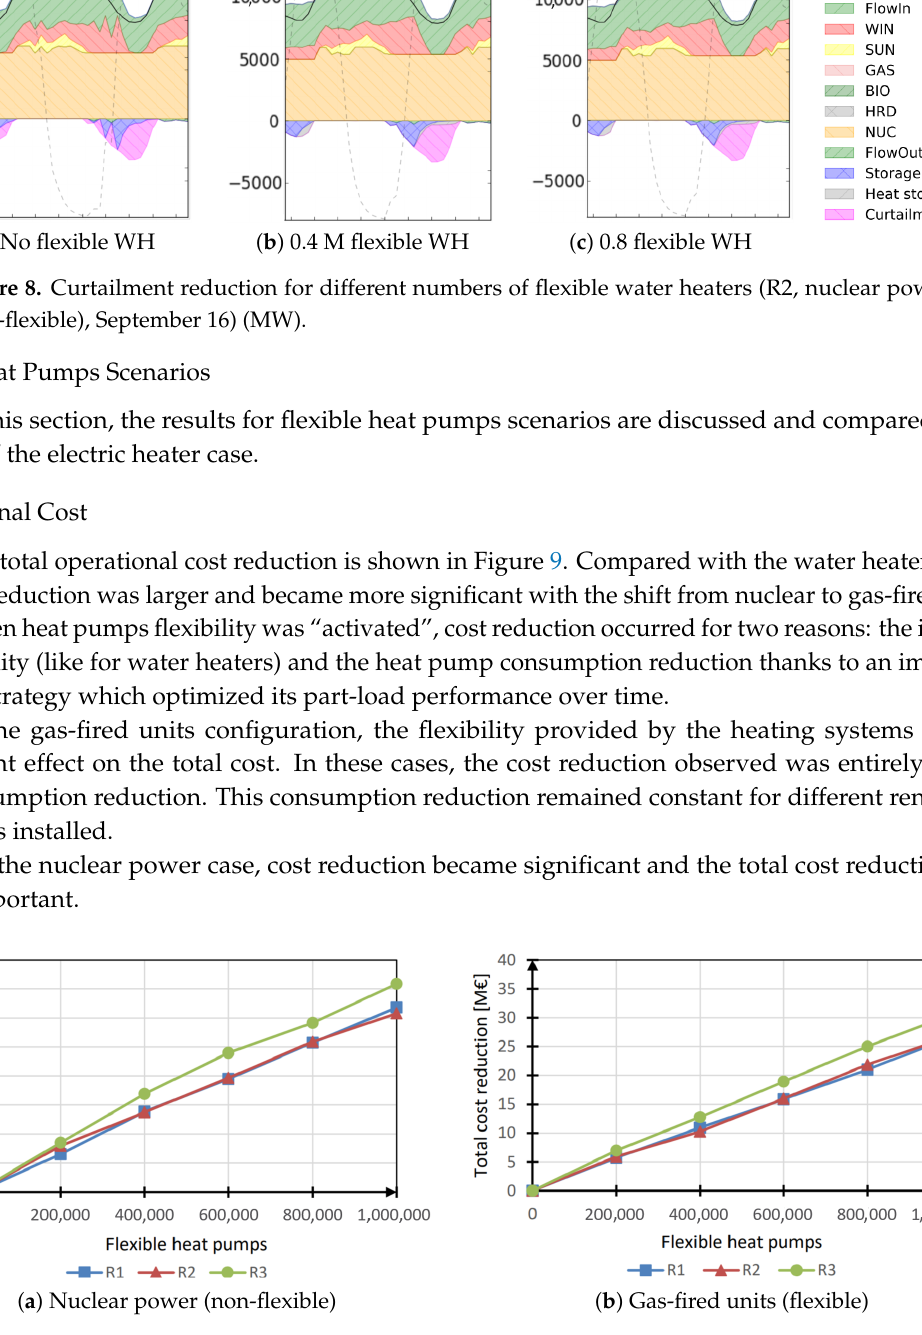
Figure 9. Total cost reduction (heat